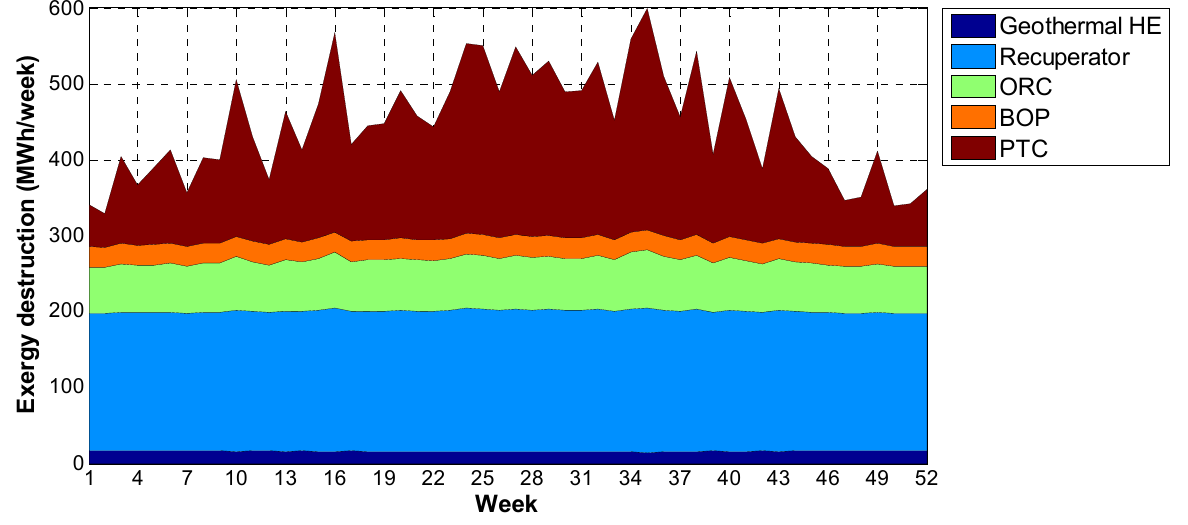
Figure 12. Weekly contribution of the exergy destruction of the different